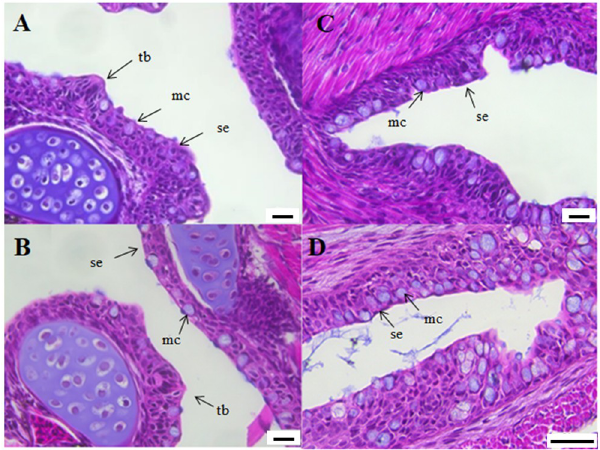
Fig 4. Longitudinal sections of the pharynx (A-B) and esophagus (C-D) of diploid and triploid Atlantic salmon at start-feeding (0 ddPSF. (A) Diploid individual (2n). (B) Triploid individual (3n). (C) Diploid individual (2n). (D) Triploid individual (3n). mc. mucus cells; se. squamous epithelium; tb. taste buds. Scale. A-C. 20 μ m. D. 50 μ m.